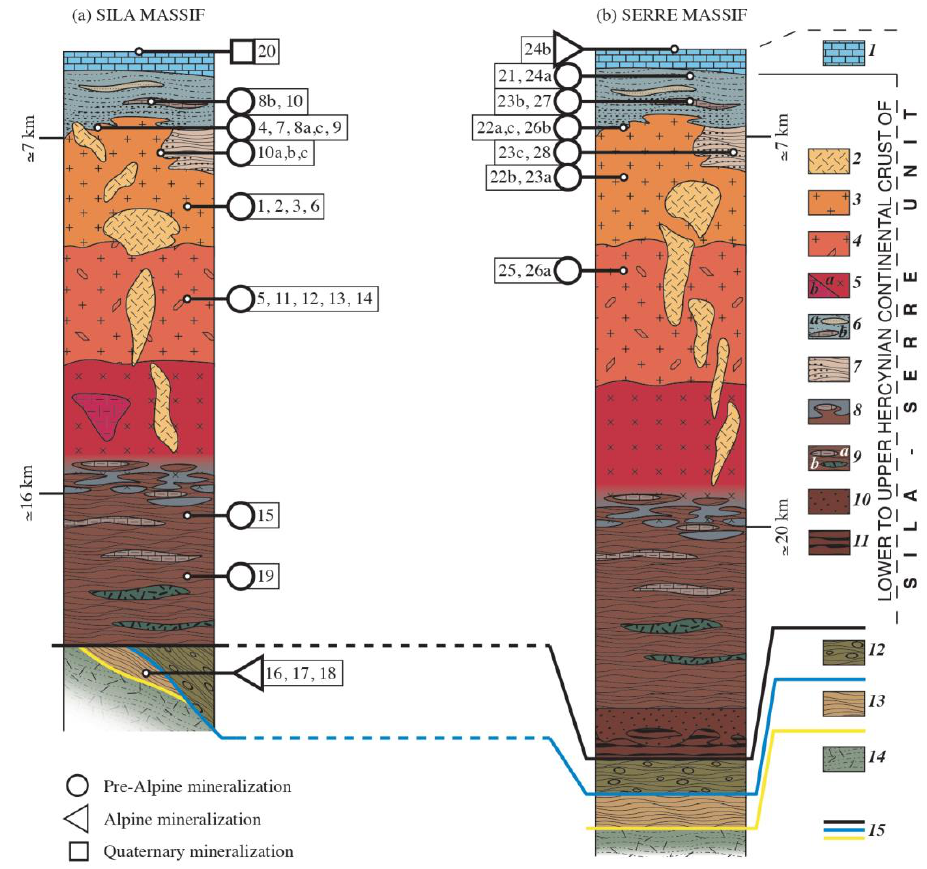
Figure 4. Schematic stratigraphic columns of the Sila-Serre Unit, in the Sila ( a ) and Serre ( b ) areas (modified after [71]), with numbered location of pertaining mineralization sites (numbers 1–28 in the squares are the same as reported in Tables A1 and A2, and in paragraphs 4 and 5) framed in the different structural levels; the Alpine Castagna, Fiume Pomo and Ophiolite units are also reported. 1—Longobucco/Stilo cover. 2—Peraluminous granites. 3—Granodiorites and granites. 4—K-feldspar megacryst-bearing granodiorites. 5—Quartz-diorites to tonalites. 6—Slates, phyllites with interbedded ( a ) marbles and ( b ) metavolcanites of the Bocchigliero and Stilo-Pazzano units, derived from Cambrian to Carboniferous protoliths (dots indicate the metamorphic contact aureole). 7—Micaschists of the Mandatoriccio and Mammola units (dots indicate the metamorphic contact aureole). 8—Migmatitic border zone. 9—Migmatitic paragneisses with interbedded ( a ) mar- bles and ( b ) metabasites. 10—Felsic granulites. 11—Layered metagabbroic rocks. 12—Castagna Unit. 13—Fiume Pomo Unit. 14—Ophiolite units. 15—Alpine tectonic contacts (line colors as in Figures 2 and